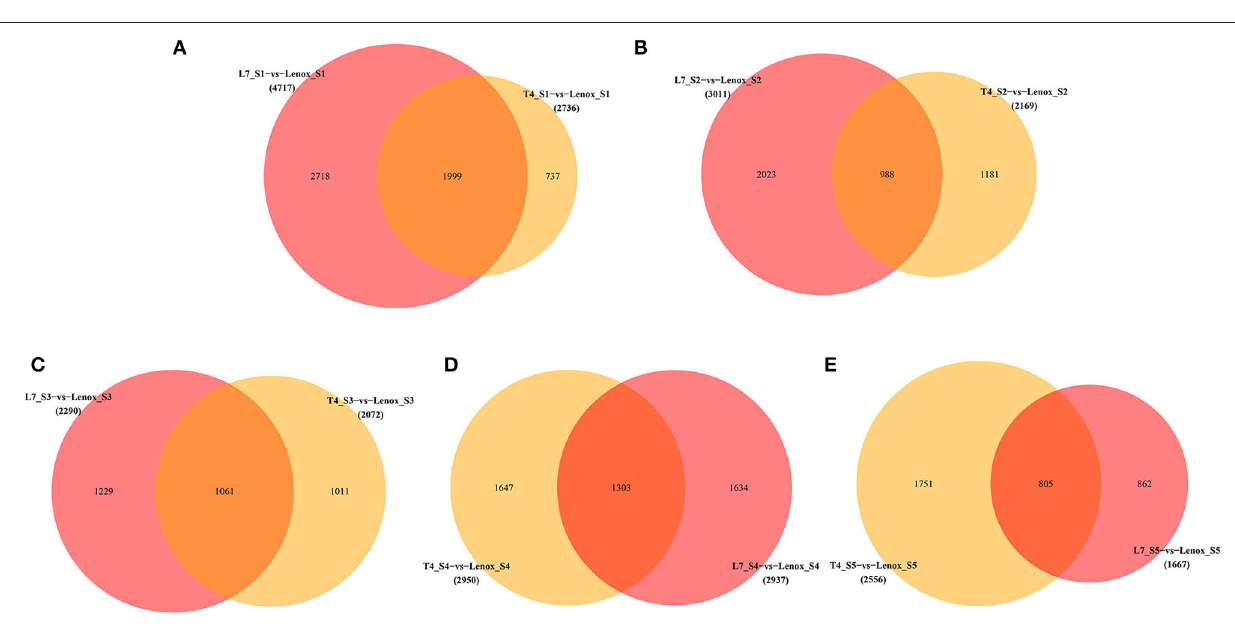
and 2,388 uniquely expressed DEGs in the four stages (S2– S5), respectively. Overall, the lowest number of stage-specific